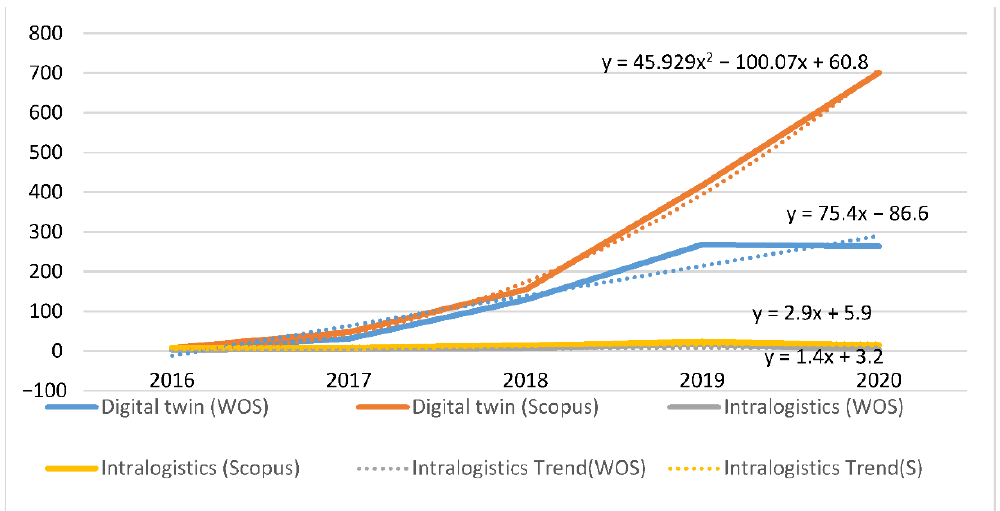
Figure 10. Trends in publications related to terms in H1 and H2.